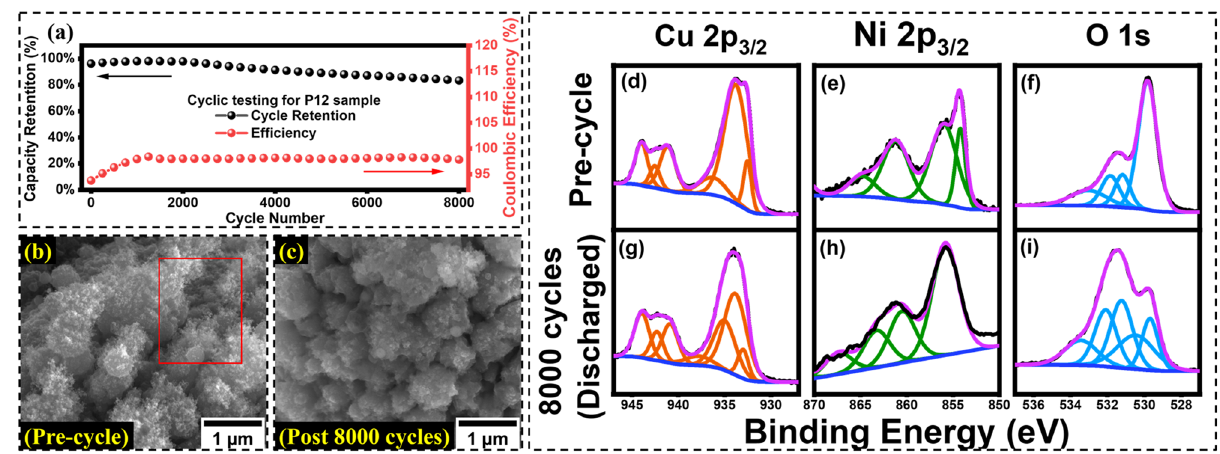
Figure 8. ( a ) Cycle retention of 83% achievable after 8000 cycles and 98% coulombic efficiency of the P12 sample. ( b ) SEM images of pre-cycle P12 sample ( c ) SEM images of P12 post 8000 cycle CD testing ( d – f ) Pre- cycle XPS deconvoluted signals ( g – i ) Post 8000 cycle XPS deconvoluted signals at a discharged